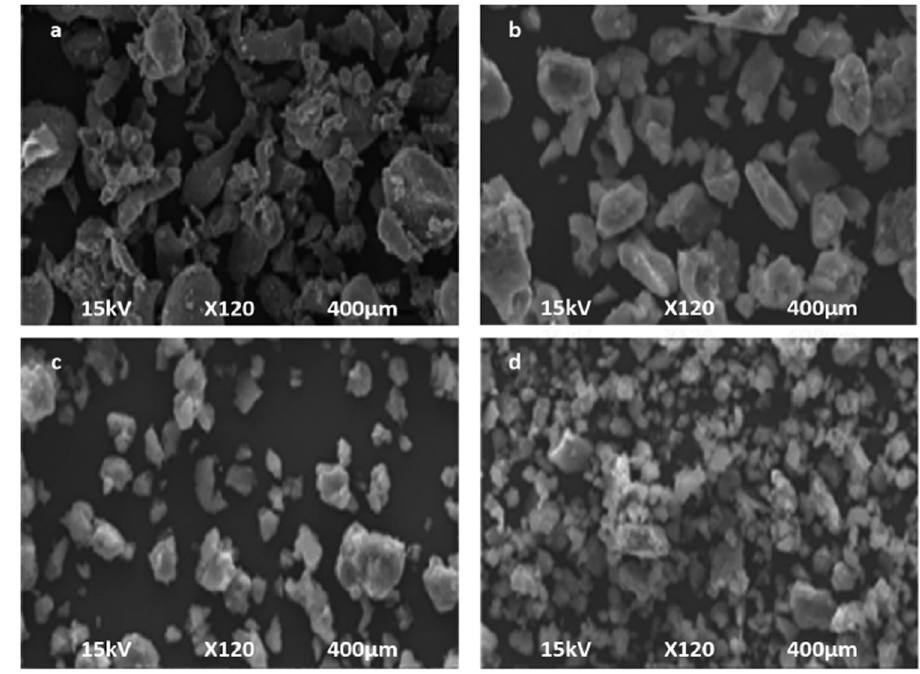
Figure 10: SEM micrographs of Al powder at, ( a ) 5 h; ( b ) 15 h, ( c ) 25 h, and ( d ) 30 h, ballmilling time -